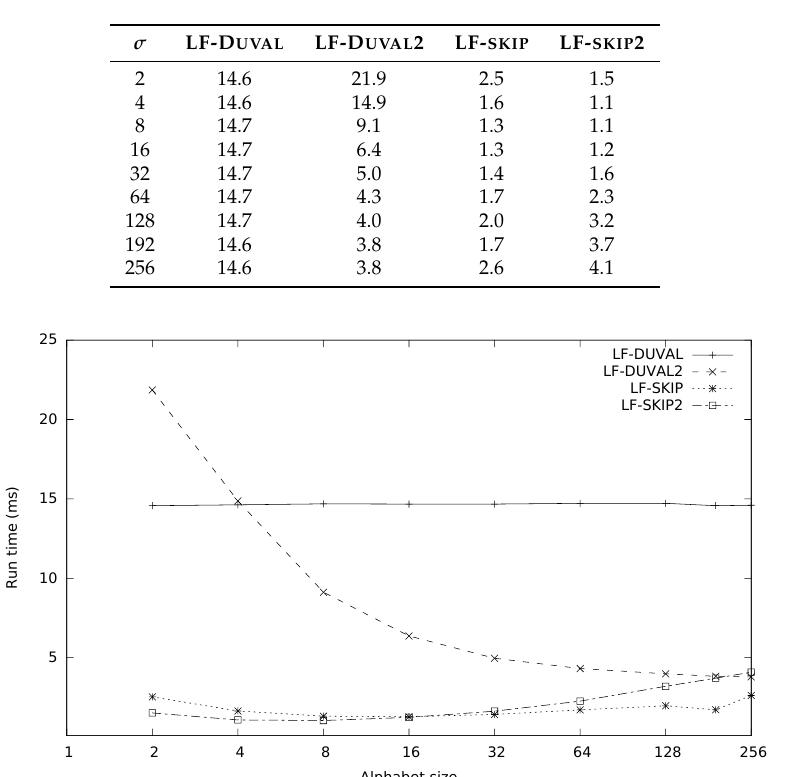
varying alphabet size.